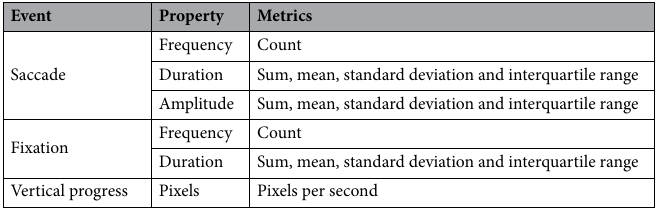
Table 2. Statistical eye movement